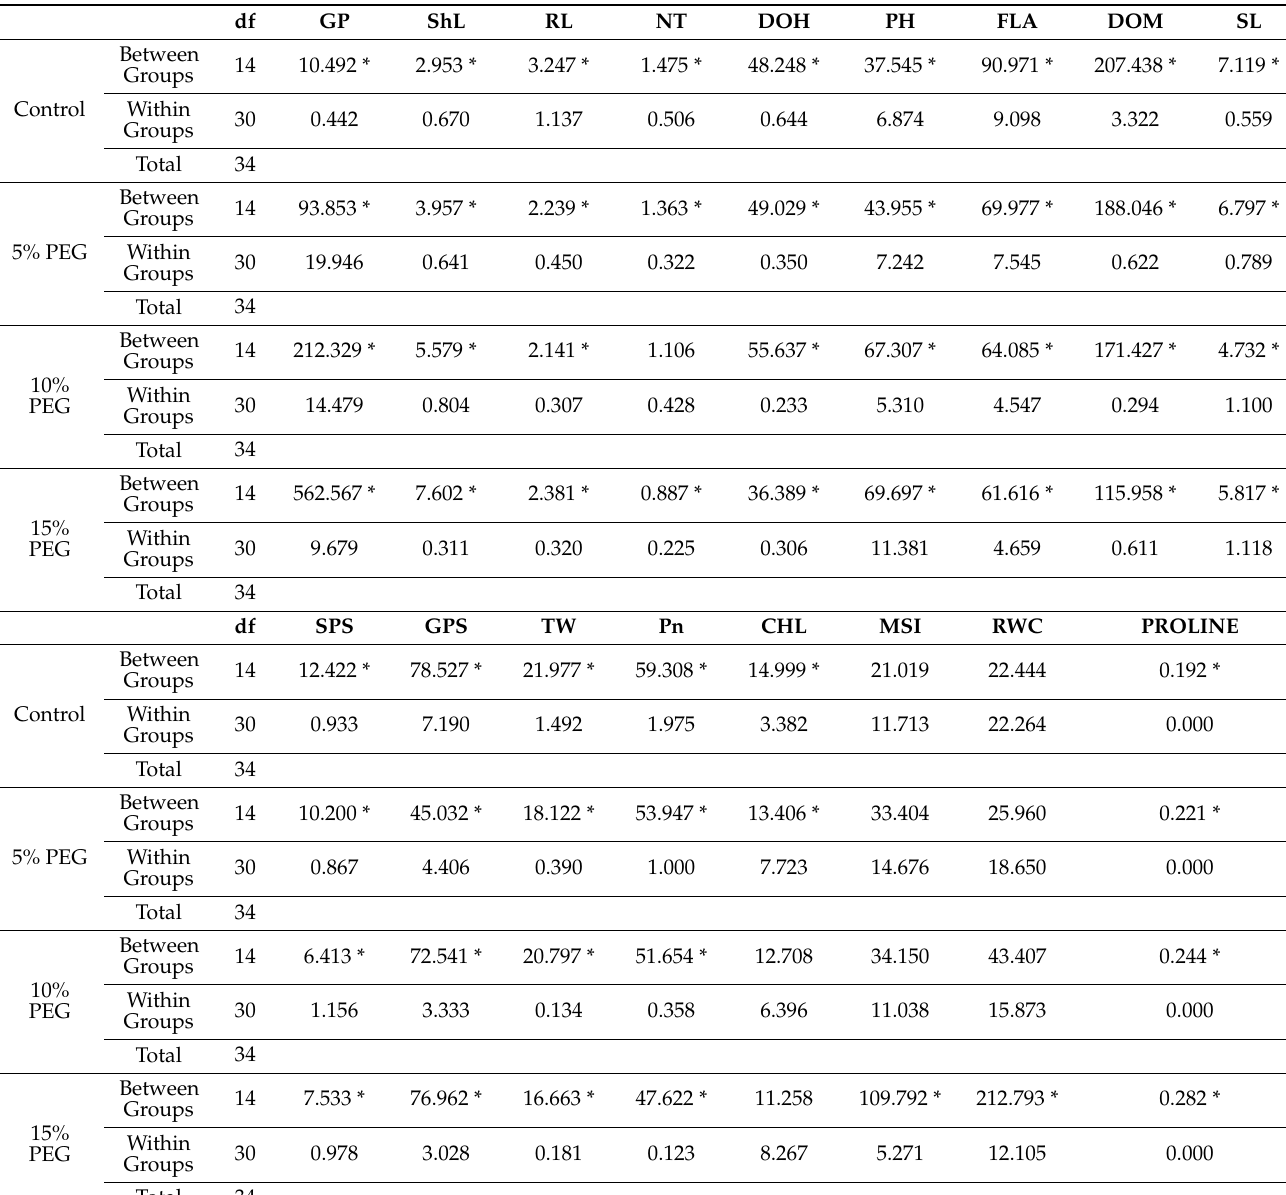
Table 2. Mean squares of morphological, physiological, and biochemical traits under control, 5% PEG, 10% PEG and 15% PEG treatment